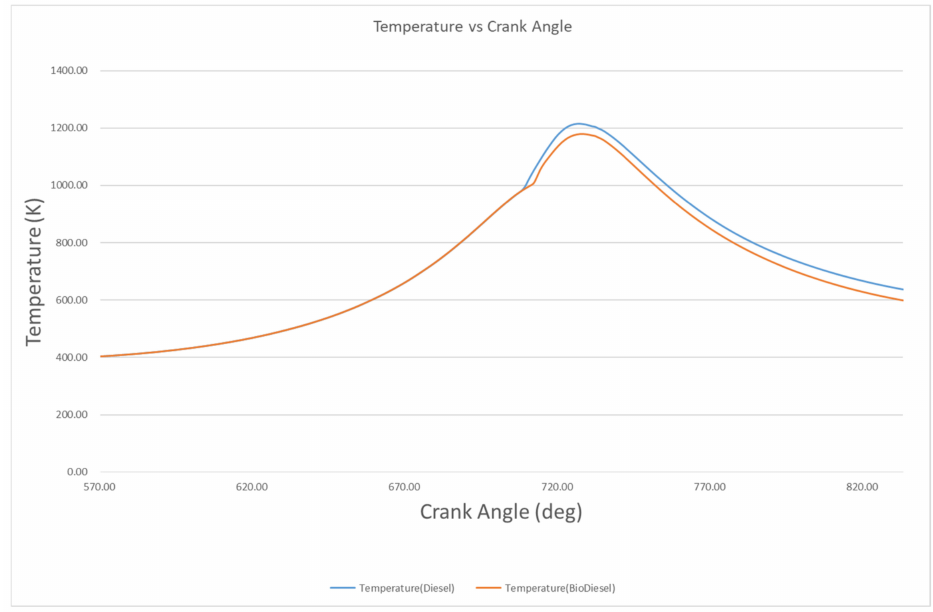
Figure 6. Temperature vs. crank angle.